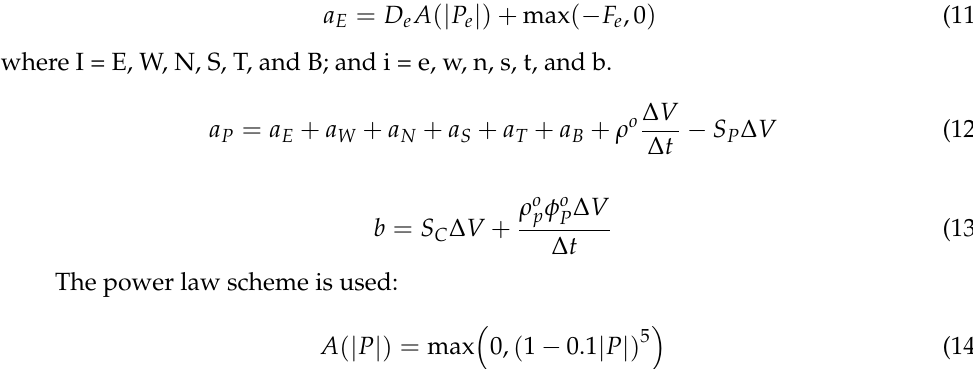
Table 1. Summary of the boundary conditions.